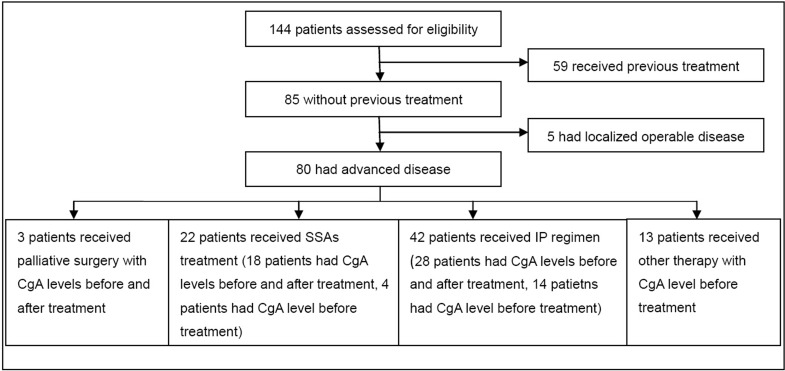
The patient screening process.IP: irinotecan plus cisplatin; SSAs: somatostatin analogs.